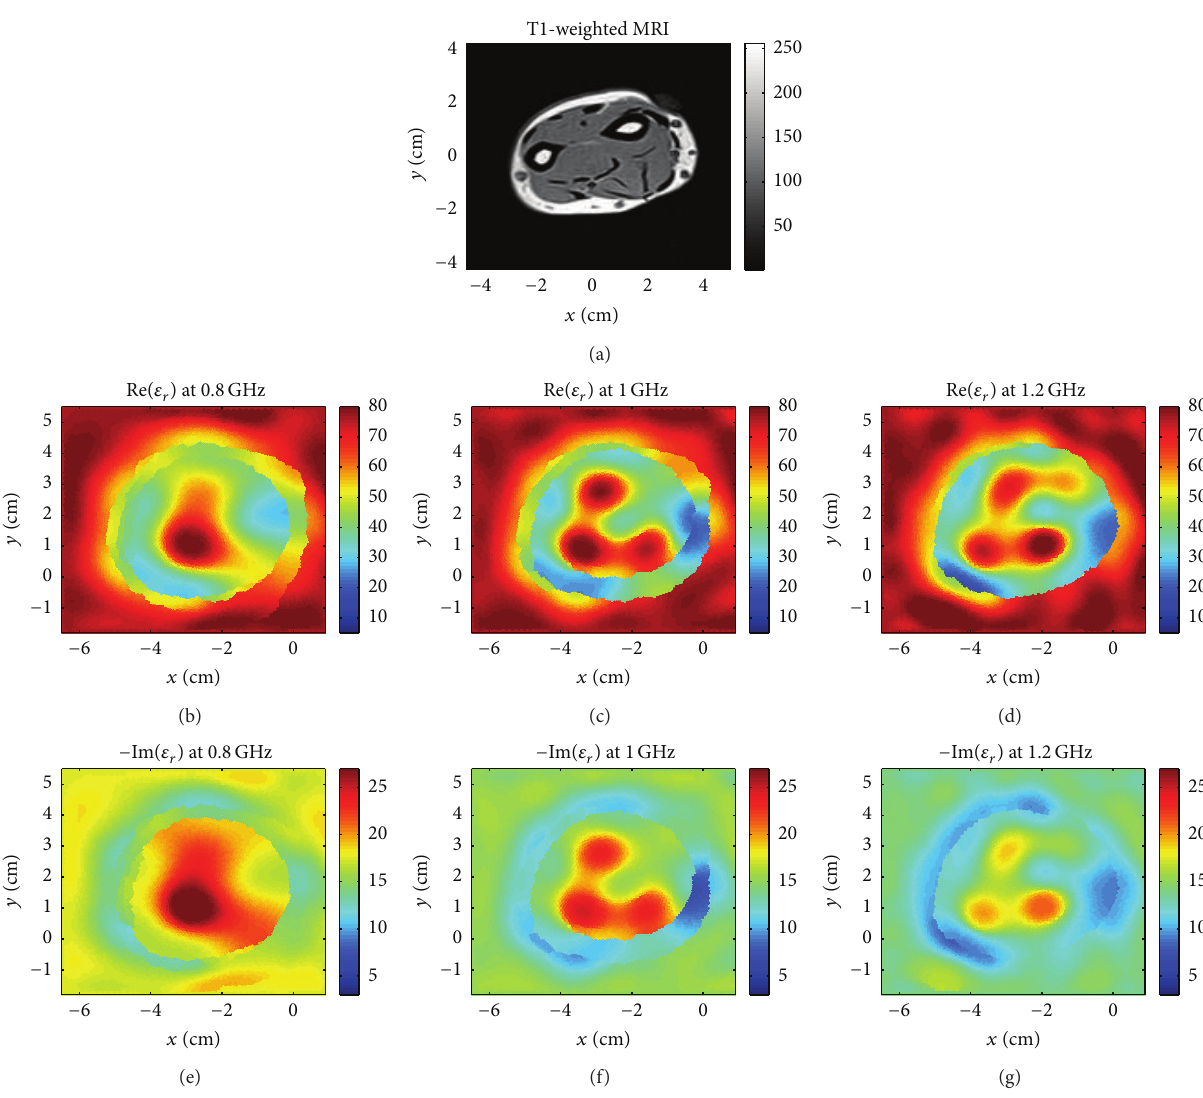
Figure 6: Volunteer 3: (a) the T1-weighted MRI image. MWI reconstructions of the relative complex permittivity real and imaginary compo- nents at (b), (e) 0.8 GHz, (c), (f) 1GHz, and (d), (g)